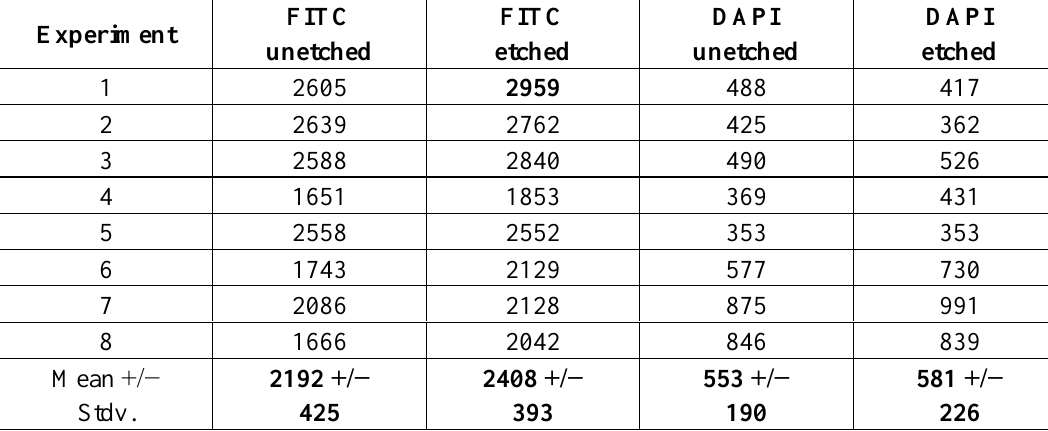
Table 2. The mean gray level of supra-threshold pixels of the cytoplasm (as indicated by FITC-labeled actin) and nuclei (as indicated by DAPI stained nuclei) for unetched and etched titanium platelets.